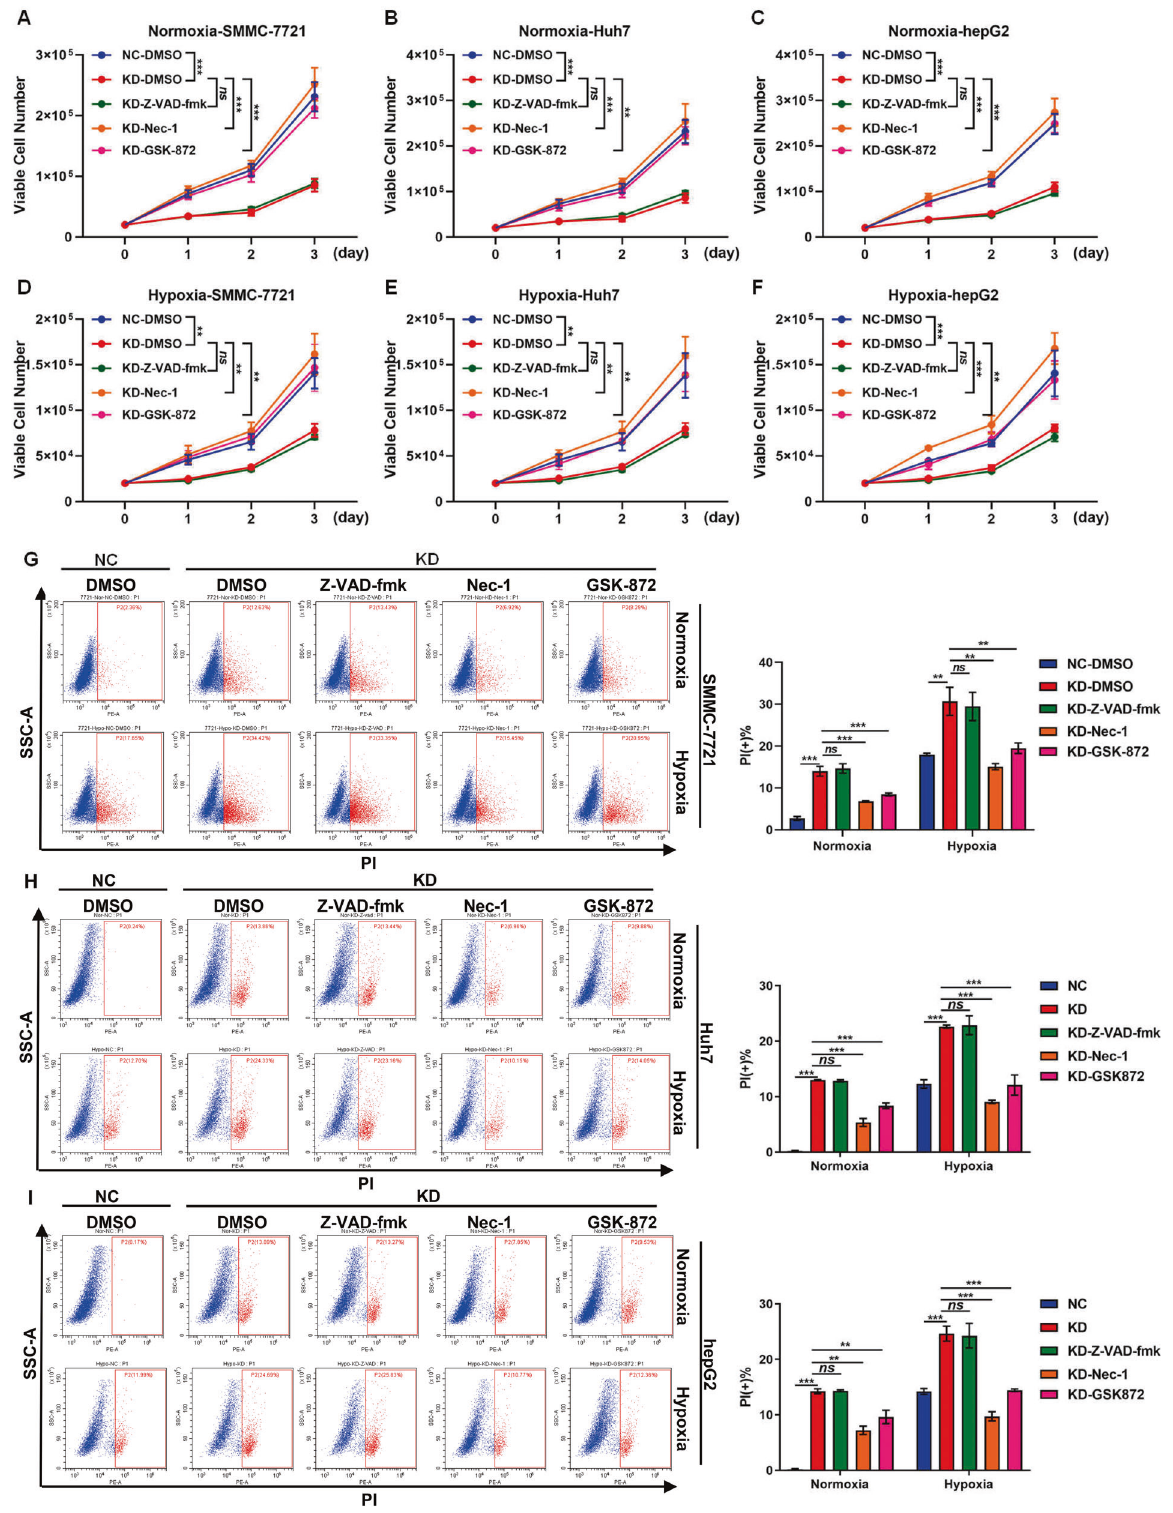
Fig. 2 Necroptosis inhibitors can rescue cell death caused by knockdown of HABON under hypoxia. A – F The expression of HABON was knockdown in SMMC-7721, Huh7 and hepG2 cells. The viable cells were counted after cultured under normoxia or hypoxia (1% O 2 ) and treated with apoptosis inhibitor (20 μ M Z-VAD-fmk) or necroptosis inhibitor (20 μ M Nec-1, 5 μ M GSK872) for different time. Three independent experiments, two-tailed Student ’ s t -test. G – I Flow cytometry was used to detect cell death after PI staining following treated with apoptosis or necroptosis inhibitor for 24 h. And the statistics of PI positive cells were shown. Error bars stand for mean ± SD. Three independent experiments, two-tailed Student ’ s t -test. * p < 0.05, ** p < 0.01, *** p < 0.001.